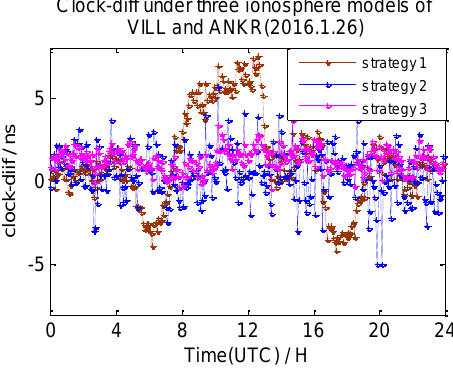
Figure 16. The clock difference under three ionosphere methods of VILL and ANKR.